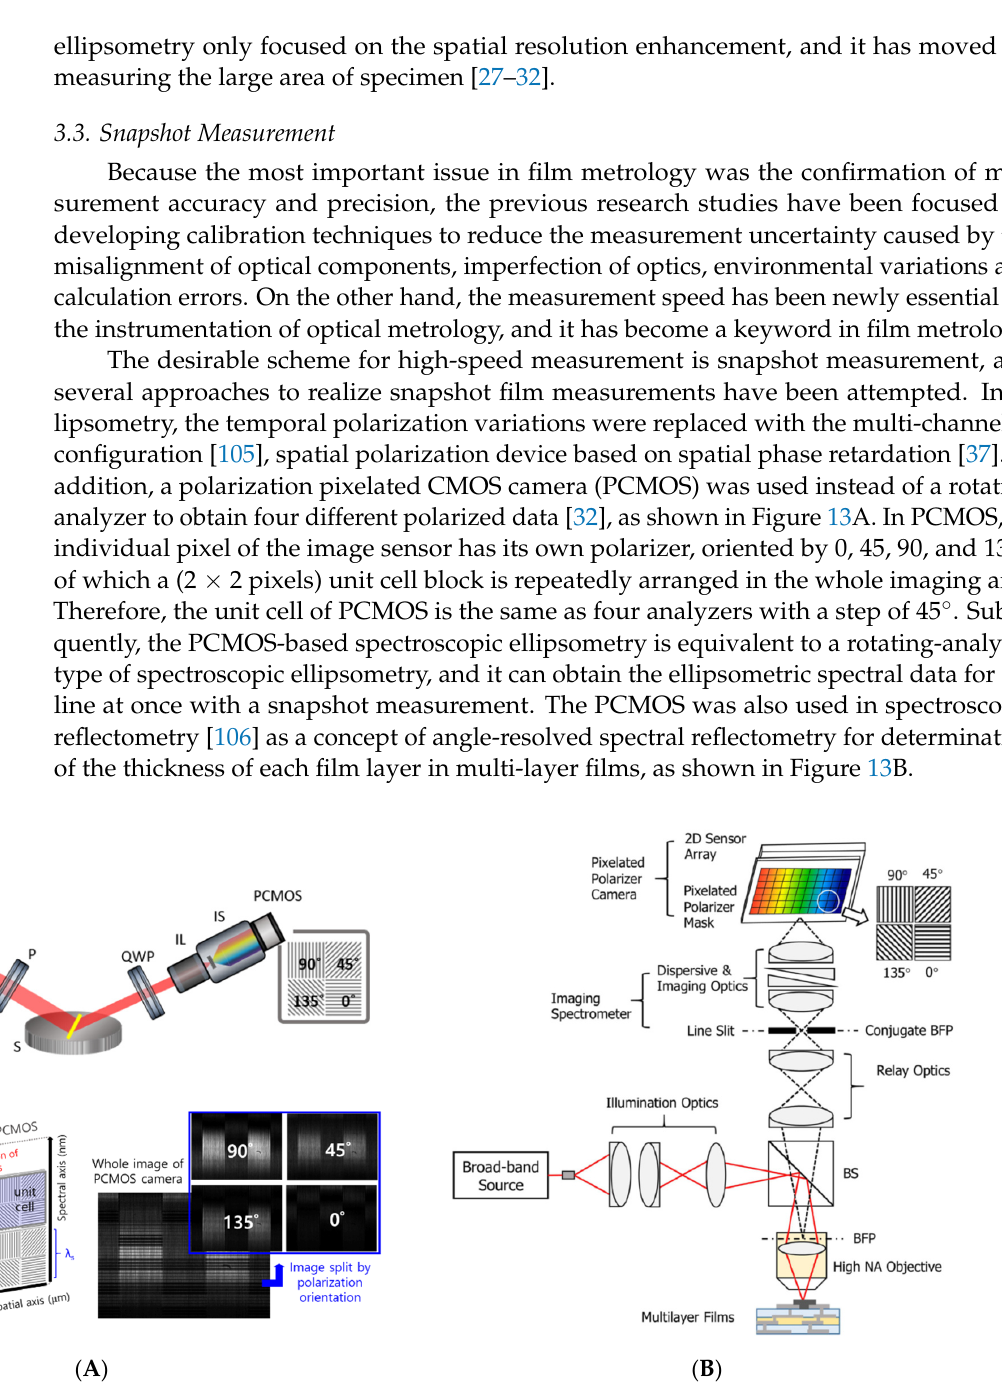
Figure 13. Schematic of ( A ) PCMOS-based spectroscopic ellipsometer (reprinted/adapted with permission from [32] © The Optical Society) and ( B ) PCMOS-based spectroscopic reflectometry (reprinted/adapted with permission from [106] © The Optical Society); BE, beam expander; P, 45 ◦ rotated polarizer; S, specimen; QWP, 45 ◦ rotated quarter-wave plate; IL, imaging lens; IS, imaging spectrometer; PCMOS, polarization ‐ pixelated CMOS camera.